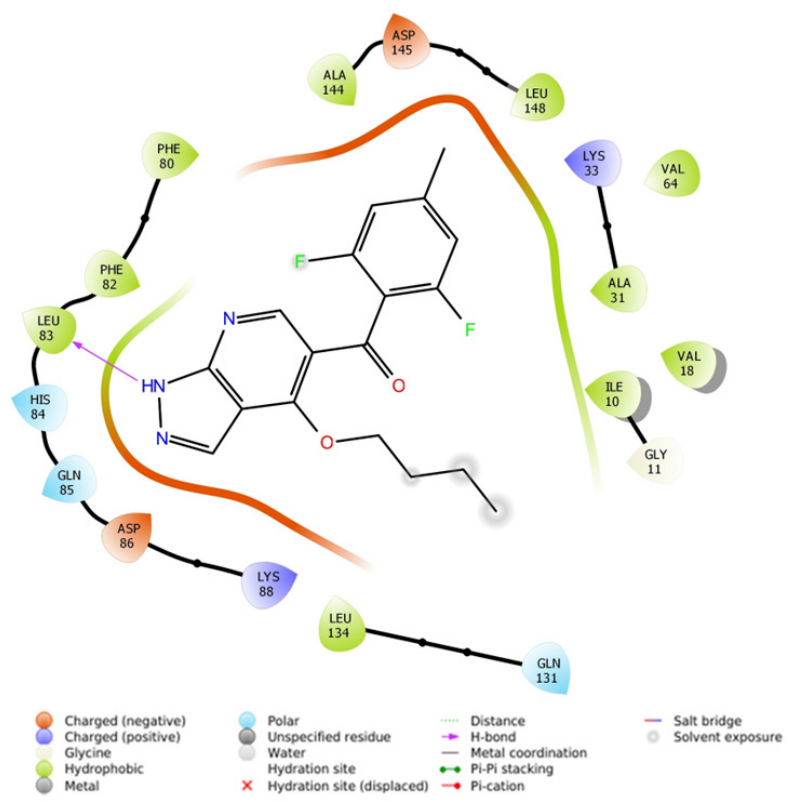
Figure 8. Two-dimensional interactions of BMS-265246 within the ATP binding pocket of CDK2 kinase.